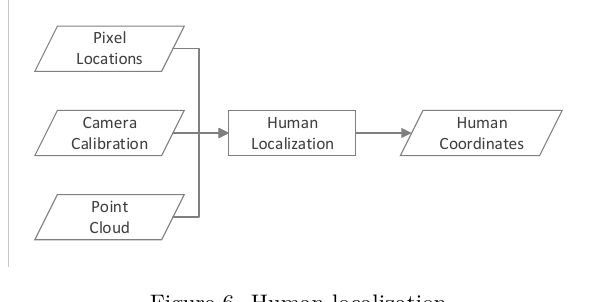
Figure 6. Human localization